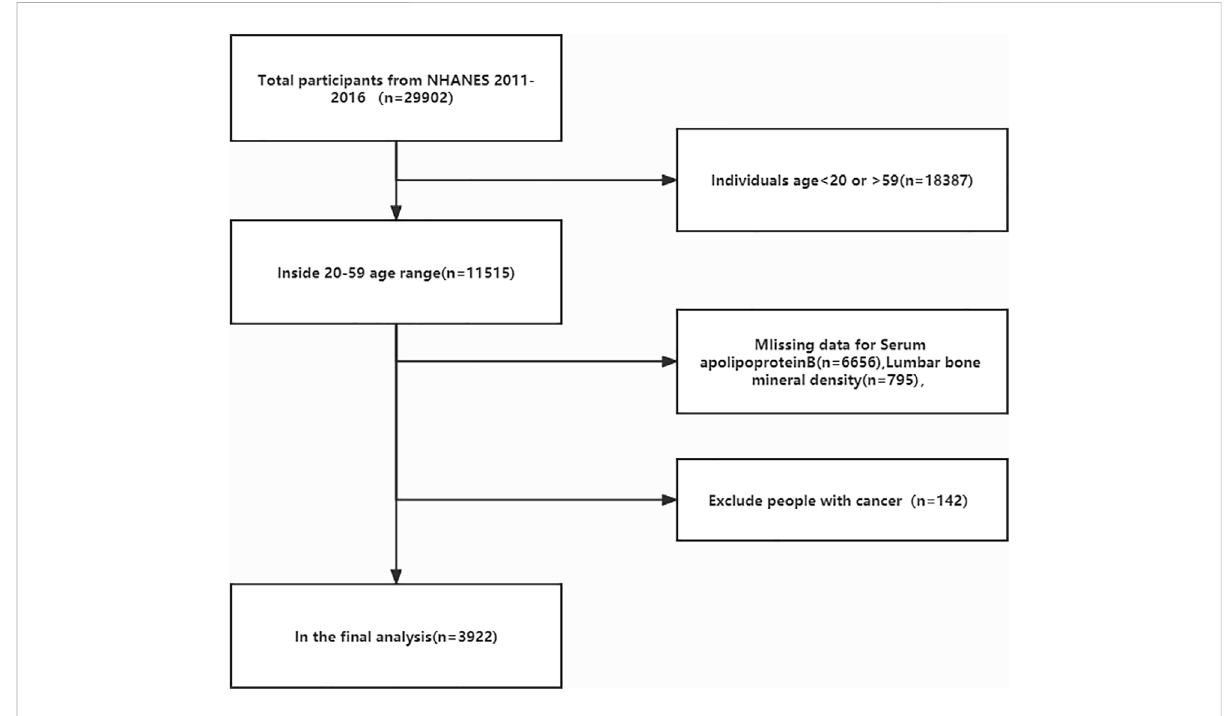
FIGURE 1 Flow diagram of the inclusion criteria and exclusion criteria. NHANES, National Health and Nutrition Examination